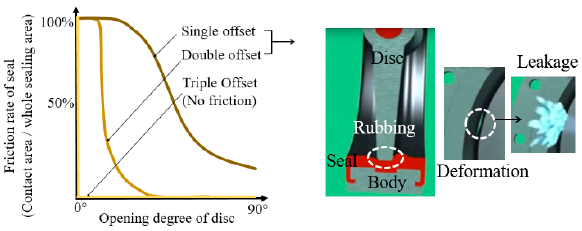
Figure 2. Friction and rubbing occurring at the single and double offset butterfly valves (SOBV and DOVB).